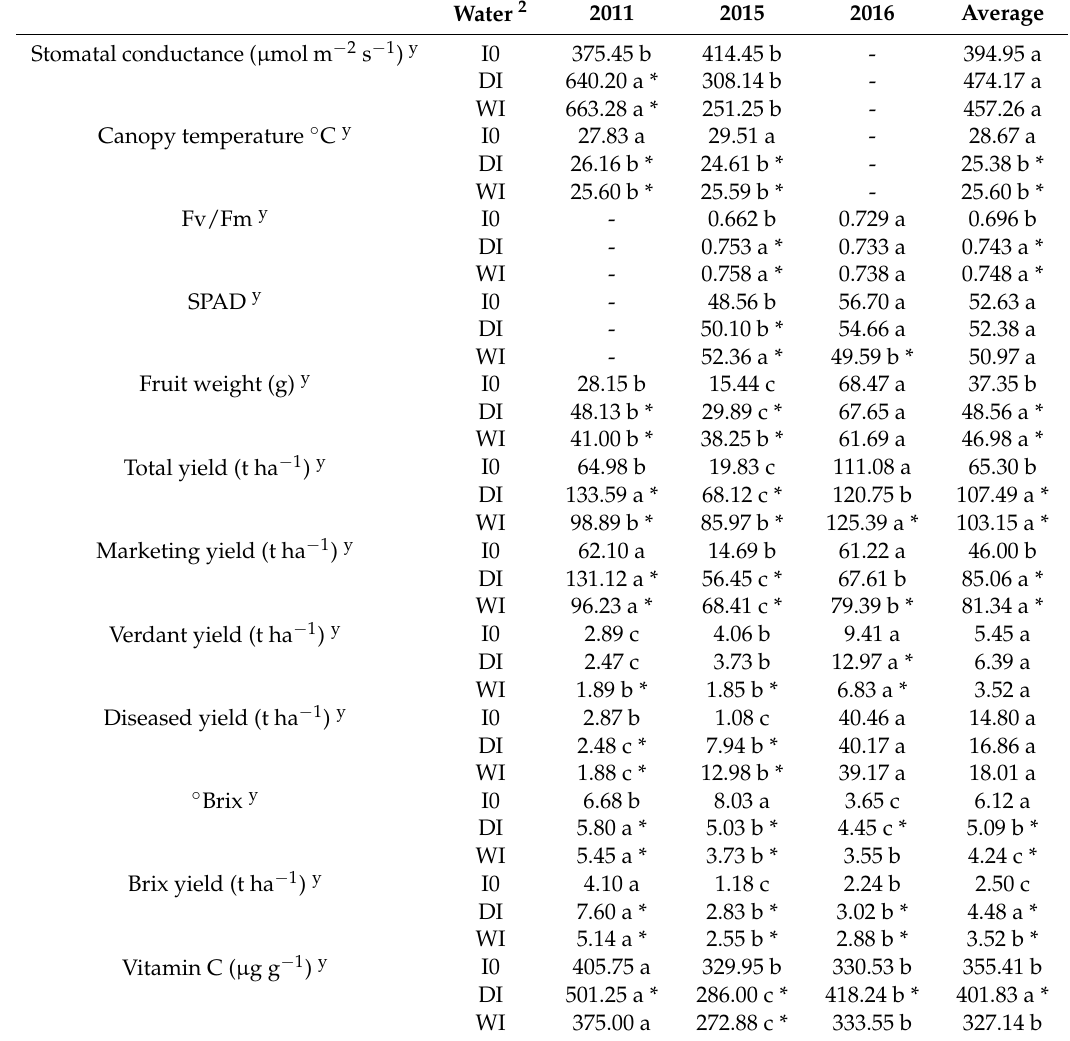
Table 2. Effect of water supply on physiological traits, yield, and quality of processing